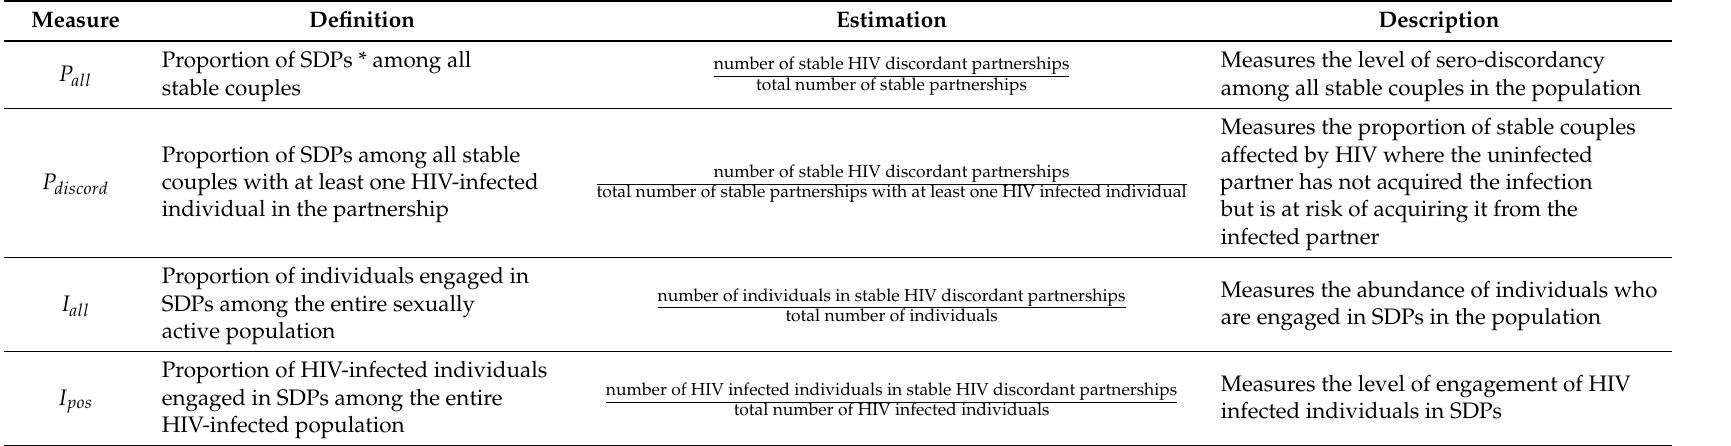
Table 1. Population-level epidemiological measures of HIV sero-discordancy